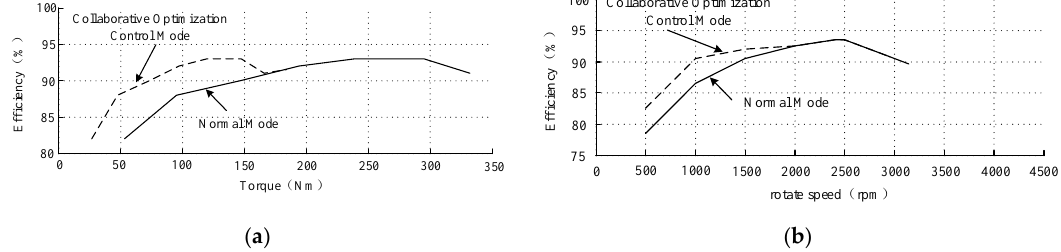
Figure 8. ( a ) System efficiency at a rotational speed of 2000 rpm; ( b ) System efficiency at a torque of 200 Nm.